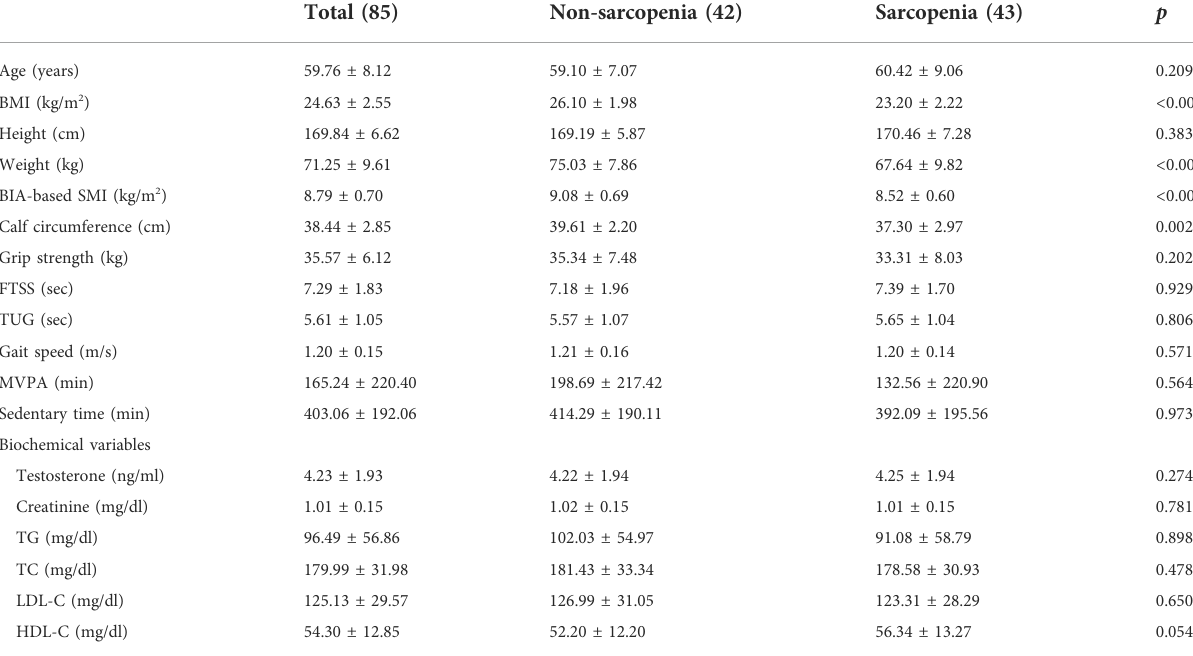
TABLE 1 Baseline characteristics and biochemical variables in